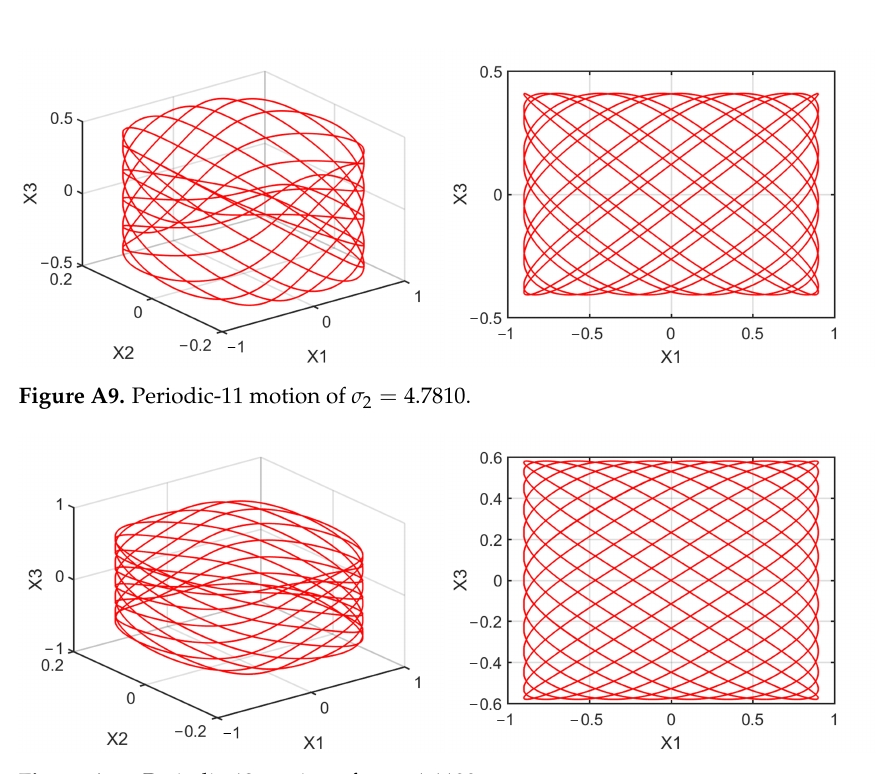
Figure A10. Periodic-13 motion of σ 2 =